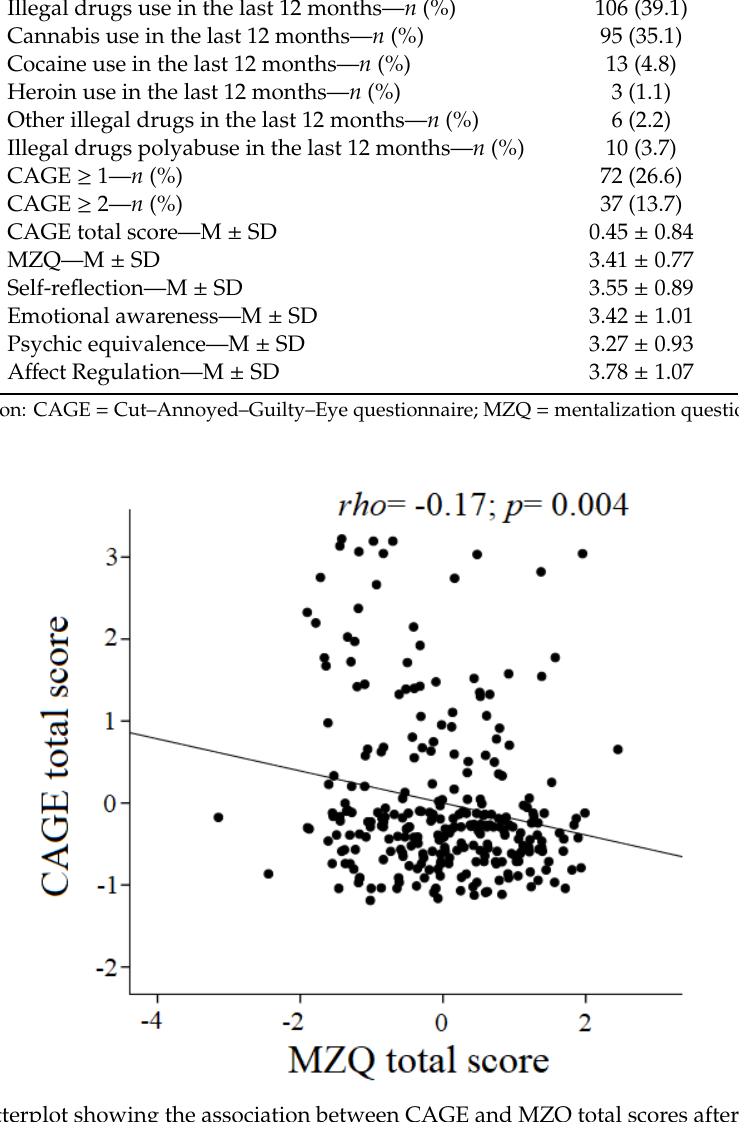
Figure 1. Scatterplot showing the association between CAGE and MZQ total scores after covering for confounding variables (gender, age, occupation, education, tobacco and illegal drugs use).